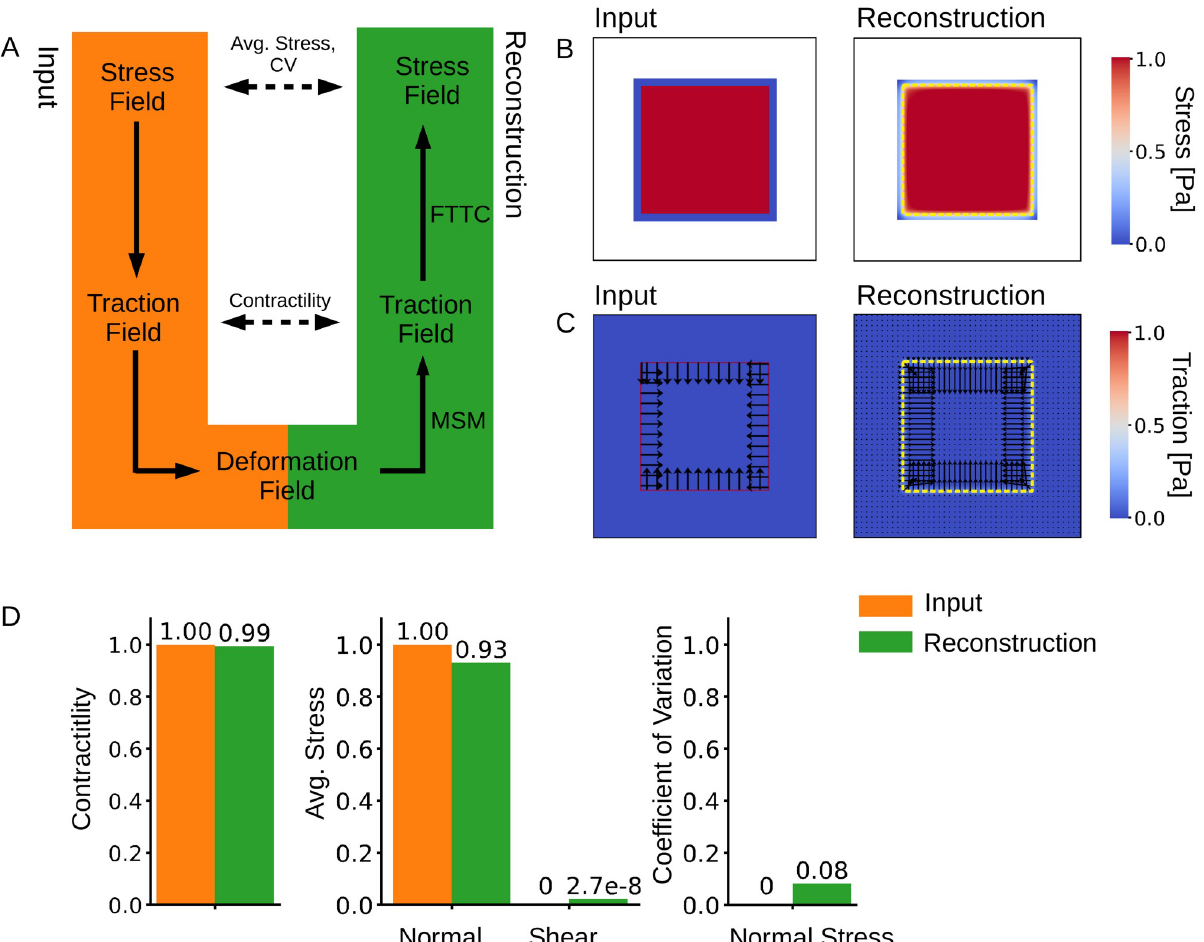
Fig 3. Accuracy of stress and traction force calculation. A: We model a cell colony as a uniformly distributed square-shaped stress field for which we analytically compute a traction field and subsequently a deformation field. We use the deformation field as the input for Traction Force Microscopy and Monolayer Stress Microscopy to recover the traction and the stress fields. B: Input and reconstructed traction field. C: Input and reconstructed stress field. The yellow dashed line shows the extent of the original stress field. D: Contractility and average normal and shear stress and CV for the mean normal stress in the input and reconstructed traction and stress fields. The contractility is computed over an area that is 12 μ m larger than the original stress field. Average normal and shear stresses and the CV of the mean normal stress are computed over the area of the original stress field.